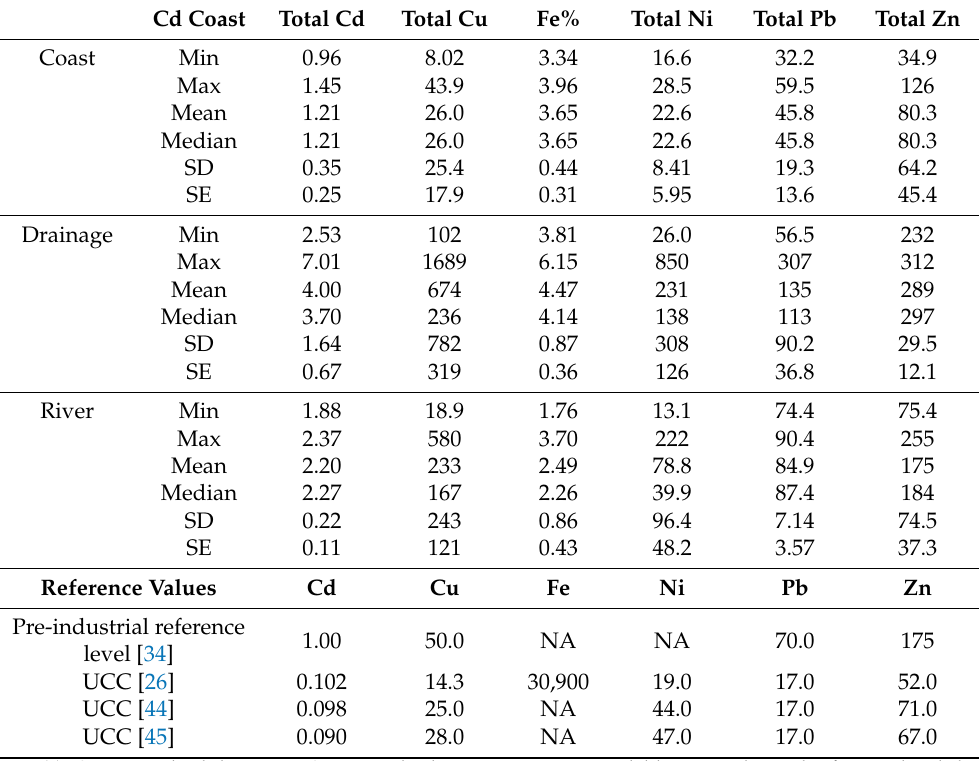
Table 2. The overall mean concentrations (mg/kg dry weight) of potentially toxic metals in sediment sampled in Peninsular Malaysia and their comparisons with pre-industrial reference levels and upper continental crust (UCC) background